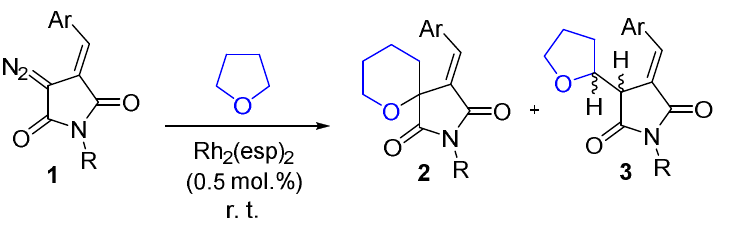
Figure 1. Typical HPLC chromatogram of a mixture consisting of 1a , 2a, and 3a components ( 3a was formed as a mixture of diastereomers).